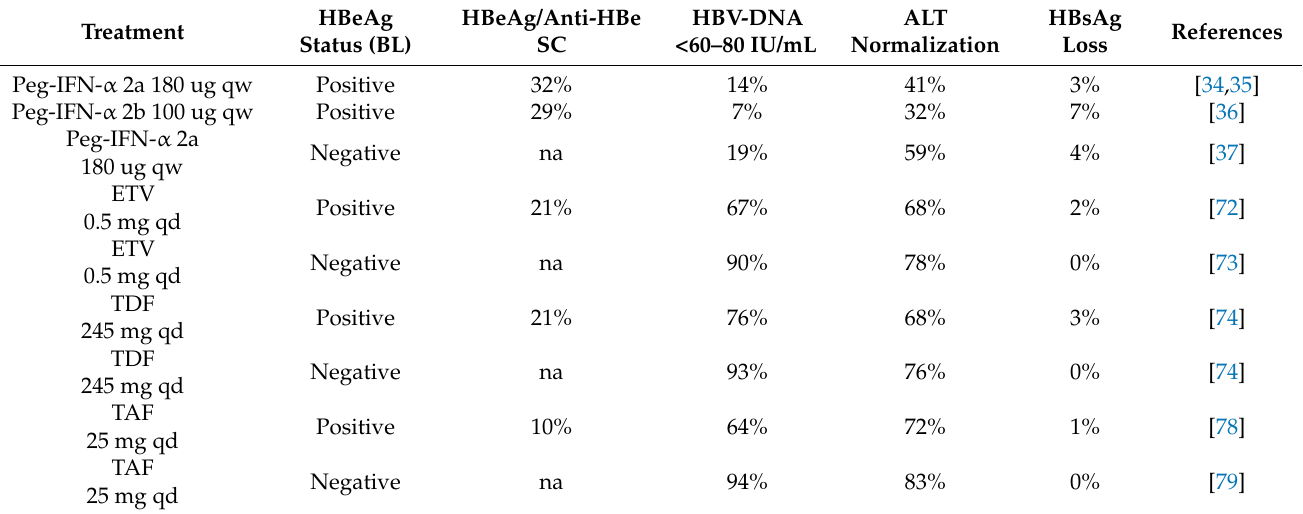
Table 1. Response 6 months after the end of 48–52 weeks of Peg-IFN- α and after 48–52 weeks of NA